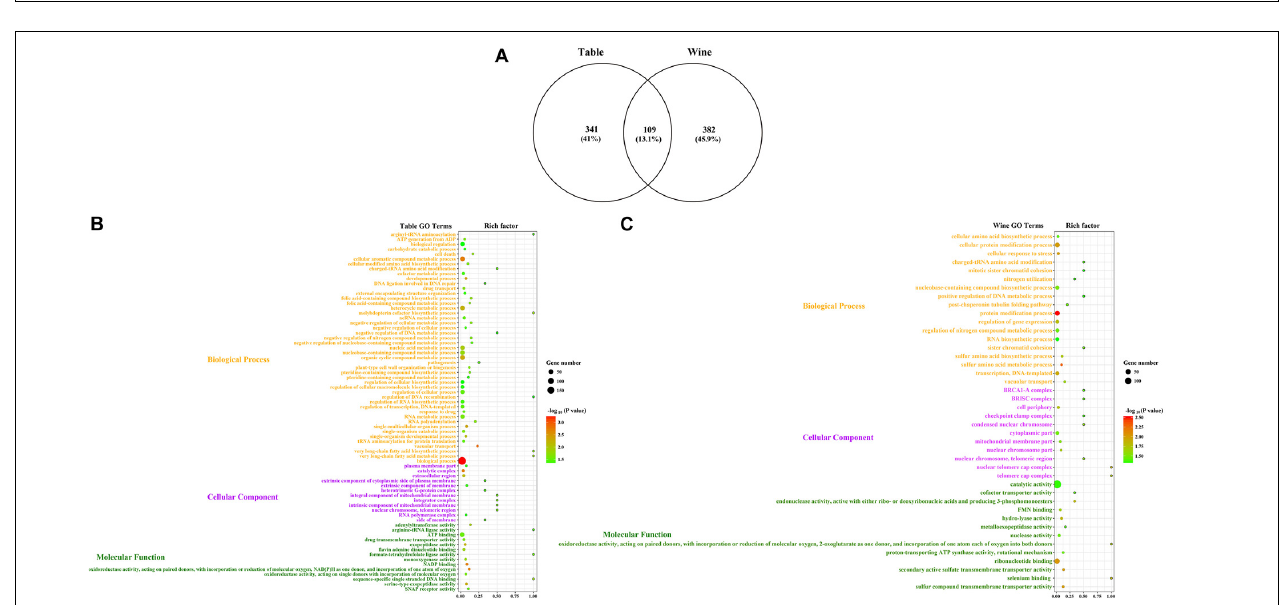
FIGURE 4 | Global View of Candidate Domesticated Regions in the table and wine grapes. Regions with both XP-CLR values and p ratios in the top 5% were regarded as having domestication signals. The admixture patterns of all accessions are presented in Figure 1C . The sources of all the samples are provided in Supplementary Table 1 .